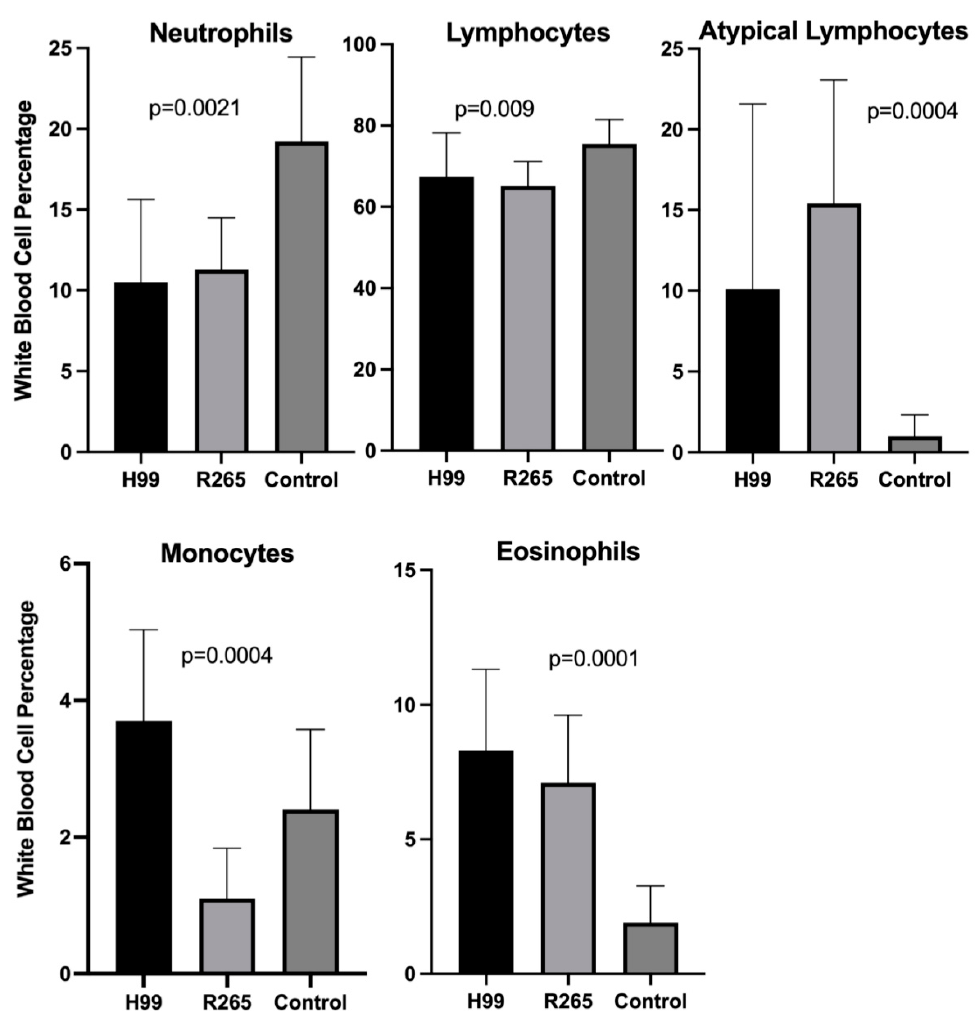
Figure 2. Variation in circulating white blood cells. Mean levels of each cell type for C. neoformans (H99), C gattii (R265), and controls in peripheral blood samples taken at day 14 post-inoculation. Error bars indicate standard deviation. p values denote significant differences between